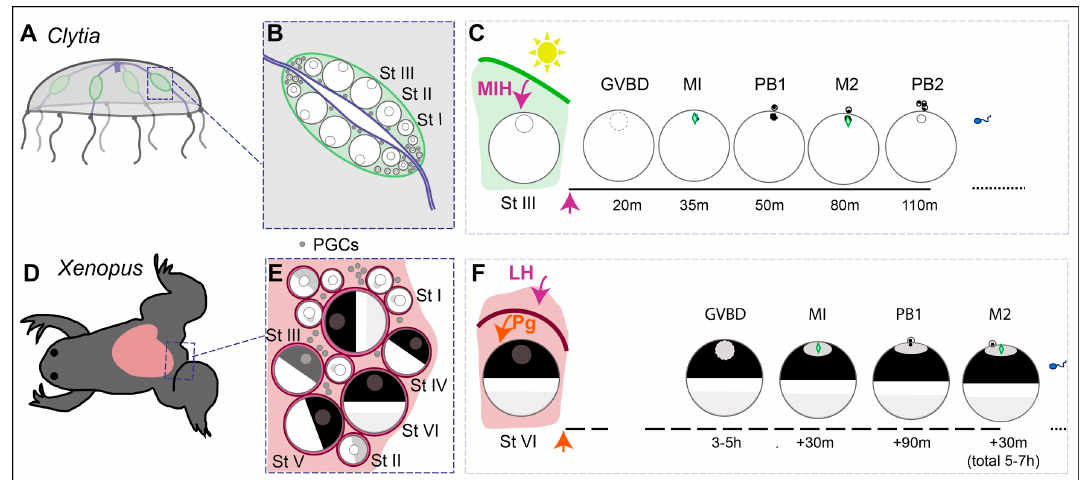
Figure 2. Overview of oocyte growth and maturation in Clytia and in Xenopus. ( A ) In Clytia adult jellyfish, oocytes develop throughout adult life in the four gonads (green), situated on each of the radial gastrovascular canals connected to the central feeding organ (blue). ( B ) Stage I, II and III growing oocytes are sandwiched between an outer ectoderm and the endodermal layer of the central gastric cavity, which directly provides nutrients for growth. ( C ) A dark–light transition each dawn causes MIH to be released from specialised cells of the gonad ectoderm. MIH acts on an oocyte GPCR leading to MPF activation, manifest as Germinal Vesicle Breakdown (GVBD), then completion of meiotic divisions MI and M2, with the emission of polar bodies PB1 and PB2, before spawning as a G1 unfertilised egg after about two hours. ( D ) In the adult Xenopus ovary (pink), the meiotic cycle of oocytes is also arrested at diplotene of the first meiotic prophase. ( E ) Growing oocytes of Stages I-VI are tightly surrounded by one layer of follicle cells and a theca (blood vessels, collagen, fibroblasts) (magenta). ( F ) Ovulation is triggered by Luteinising hormone (LH) from the pituitary, which causes follicle cells to release steroid hormones, including progesterone (Pg). These act on oocyte membrane receptors to initiate a series of events culminating with variable timing in GVBD and completion of the first meiotic division before arrest as an unfertilised egg at M2 after a total of around 5–7